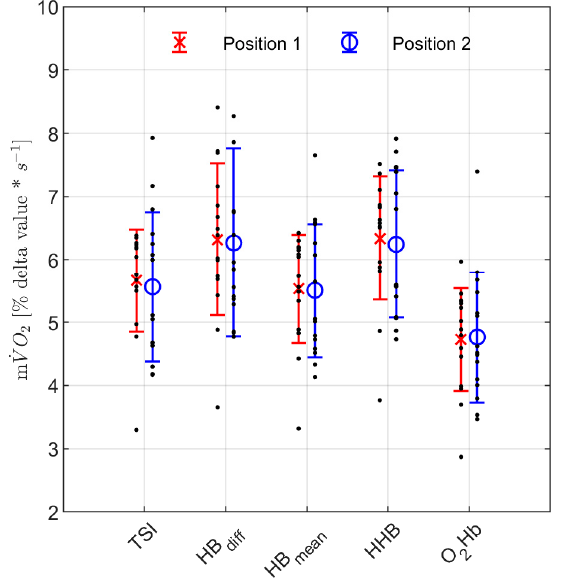
Figure 4. Estimated oxygen consumption (mV ̇ O 2 ) at the different angular positions (Position_1, Position_2) using five different approaches. Data represents mean ± standard deviation. TSI = tissue saturation index. HBdiff = difference between O 2 Hb and HHb. HBmean = mean slope out of the slopes from oxygenated and deoxygenated signal. HHb = deoxygenated signal. O 2 Hb = oxygenated signal. Note: black dots represent individual data. Table 1. Overview of Bonferroni corrected post-hoc results (p bonf ) for the main effect approaches and the percentage difference ( ± standard deviation) of the